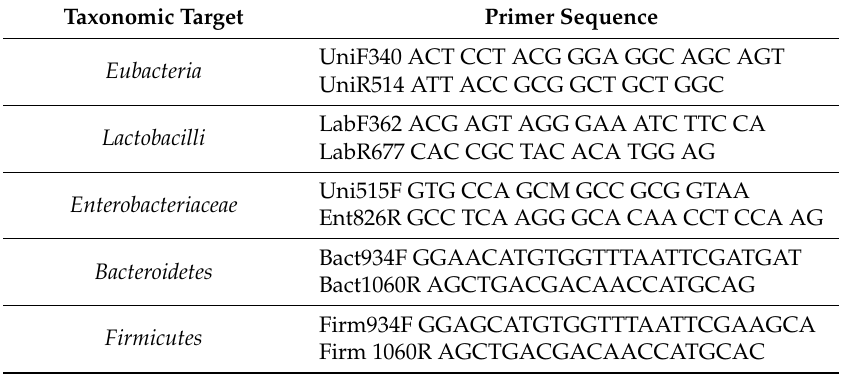
Table 1. Primer sequences used for microbiota